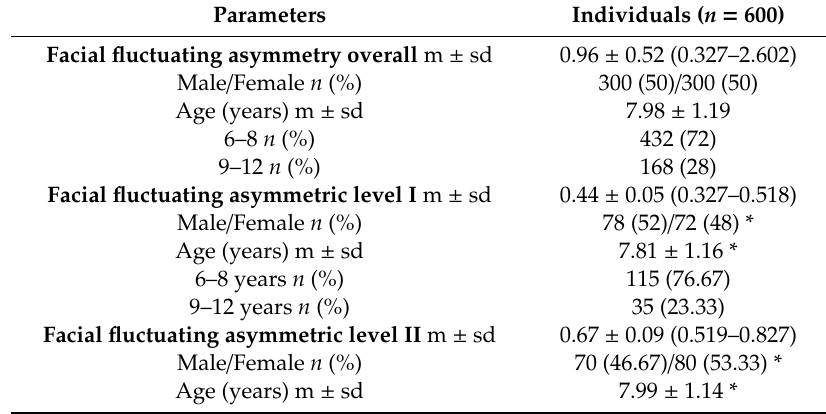
Table 1. Characteristics and levels of facial fluctuating asymmetric severity in normal pediatric